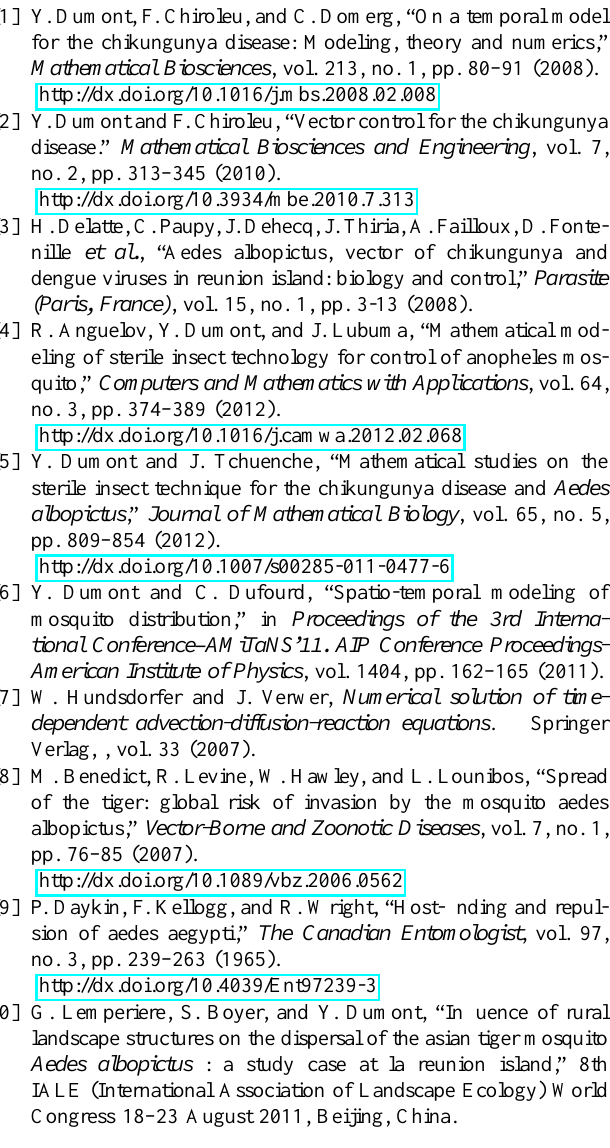
Fig. 6. Comparison of the evolution of the number of mature females with a weekly massive spraying control, and SIT with weekly releases of 2000 , 4000 , 10000 and 20000 sterile males over one month.